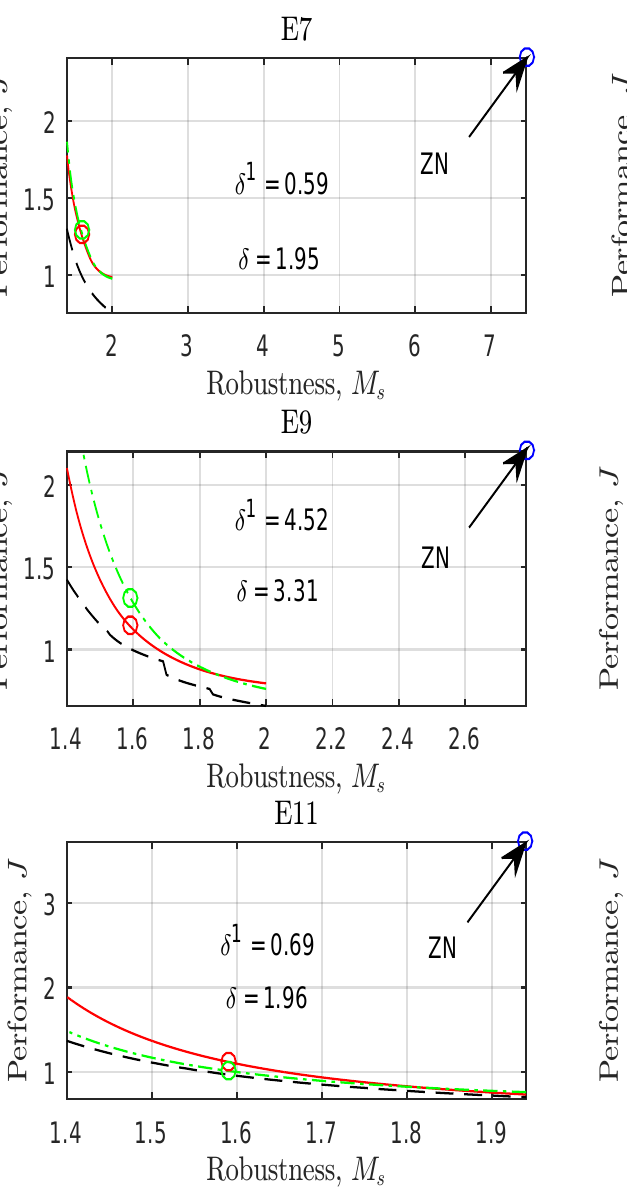
Figure 6: Es7-12. The figure shows the Pareto perfor- mance J (Eq. (7)) and robustness M s (Eq. (5)) trade-off curves for the methods δ -PRC ( δ ), Opt-PRC ( δ 1 ) and PO PID ( M s ). This figure illustrates the ZN PRC PID tuning as a single point per example. This figure is a ‘zoomed out’ version of Figure